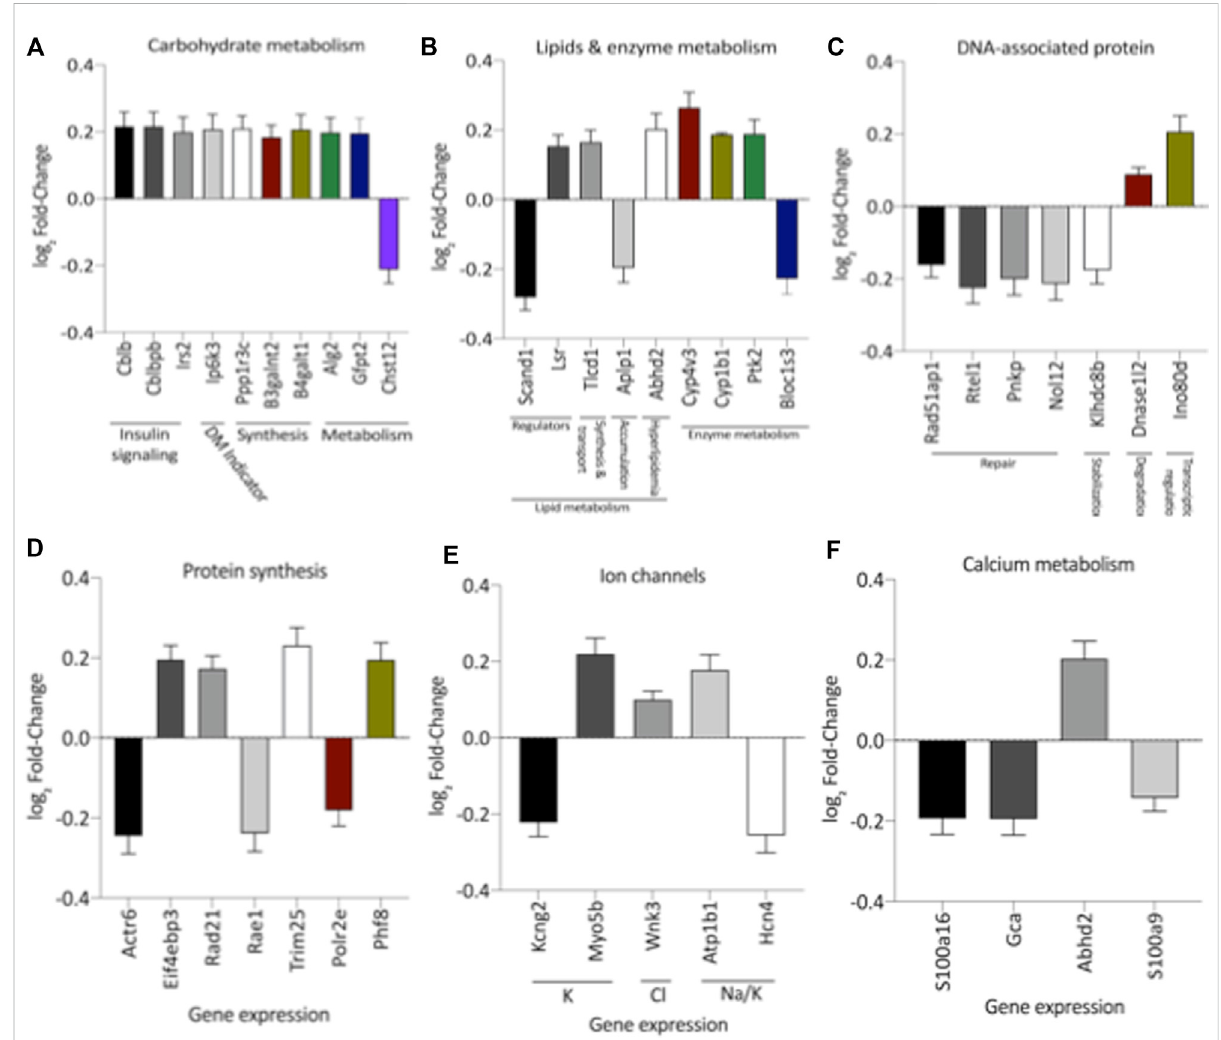
FIGURE 4 Expression of genes signi fi cantly, grouped by their role altered in carbohydrate (A) , lipids metabolism (B) , DNA-associated protein (C) , protein synthesis (D) , and Ion (E) and Calcium Channels (F) . These analyzes were performed based on pertinent literature on aging and cardiac disease (the gene's abbreviations and references are found in Supplementary Table S1). The results were expressed as mean ±